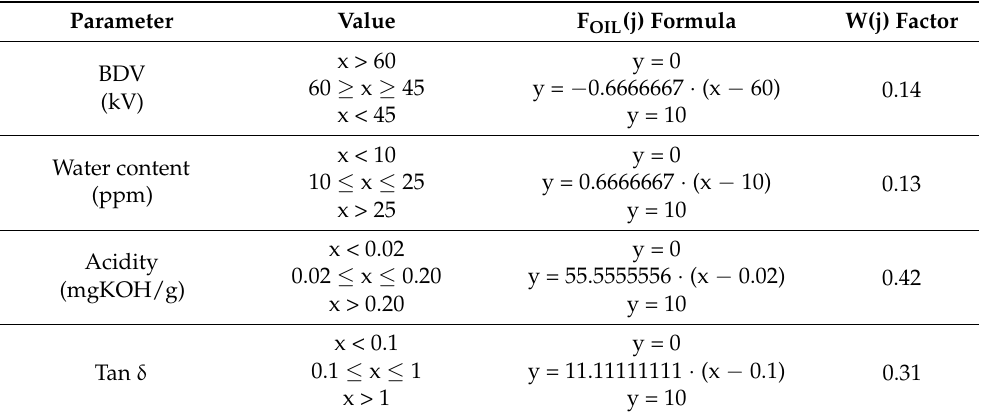
Table 3. The individual formulas and weighting factors used to evaluate the physicochemical properties of oil for transformers with the upper voltage of 69 kV < U ≤ 230 kV.